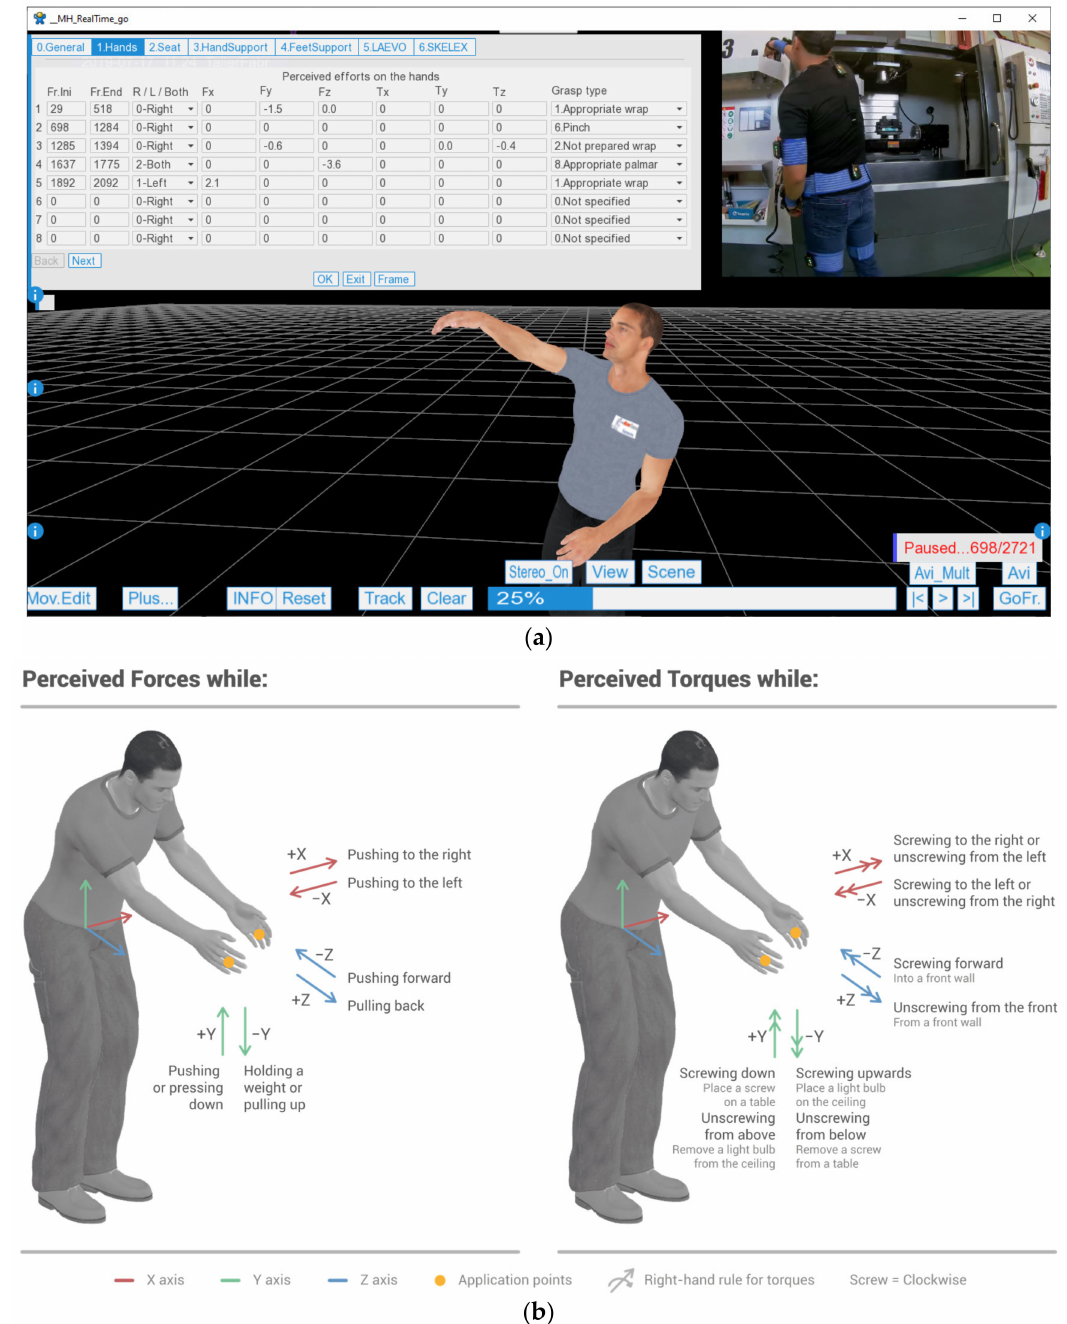
Figure 3. ( a ) Form to introduce external forces and torques exerted with the hands. ( b ) Criteria and examples of interpreting force and torque vectors are entered in the